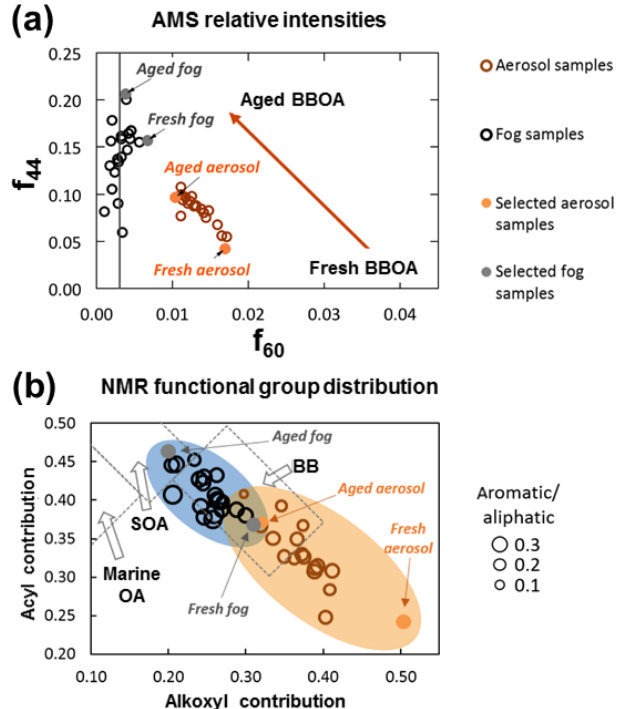
Figure 1. Preliminary characterization of fog and PM 1 aerosol sam- ples collected in SPC and Bologna, respectively, during the 2013 Supersito field campaign. Characterization was performed via HR- ToF-AMS analysis as described by Cubison et al. (2011), utiliz- ing the relative intensity of peak m/z 60 ( f 60 ) and peak m/z 44 ( f 44 ) as markers of fresh biomass burning influence and oxygenated and processed dissolved organic molecules, respectively (a) . Fur- ther characterization was performed via 1 H-NMR analysis, as de- scribed by Decesari et al. (2007), where samples were mapped by 1 H-NMR functional group fractions (b) . In (b) , dashed lines indi- cate the boundaries of the source fingerprints according to Dece- sari et al. (2007; “BB”: biomass burning aerosol), and the x and y axes report the contributions of alkoxyl (HCO) and acyl (HCC = O) groups to the total aliphatic fraction of WSOC, respectively. The sample names fresh fog, aged fog, fresh aerosol, and aged aerosol correspond to SPC0106F, SPC0201F, BO0204N, and BO0213D, re-